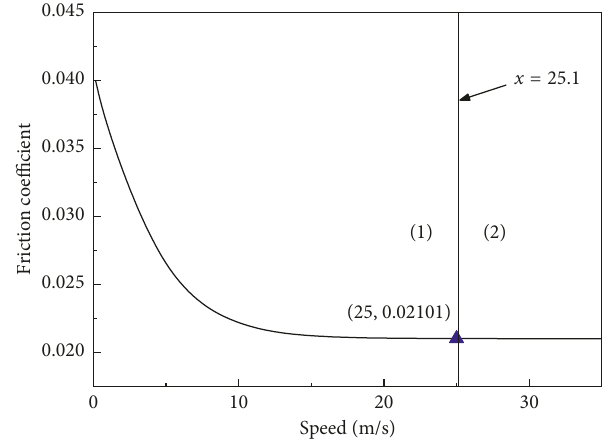
Figure 12: Friction coefficient response of No. 5 stand versus